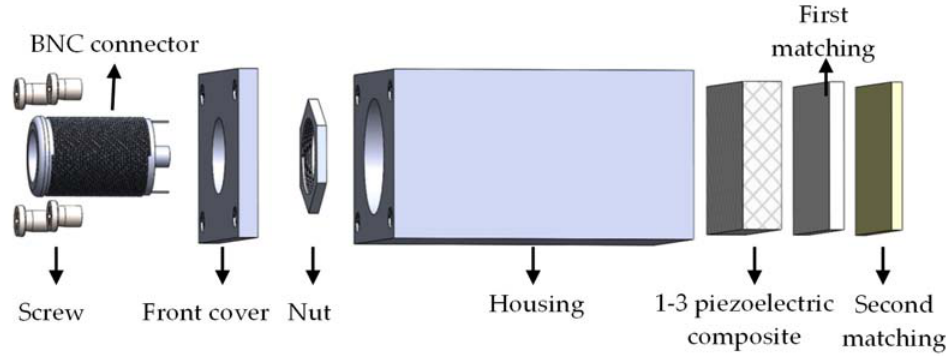
Figure 2. Structure of air ‐ coupled